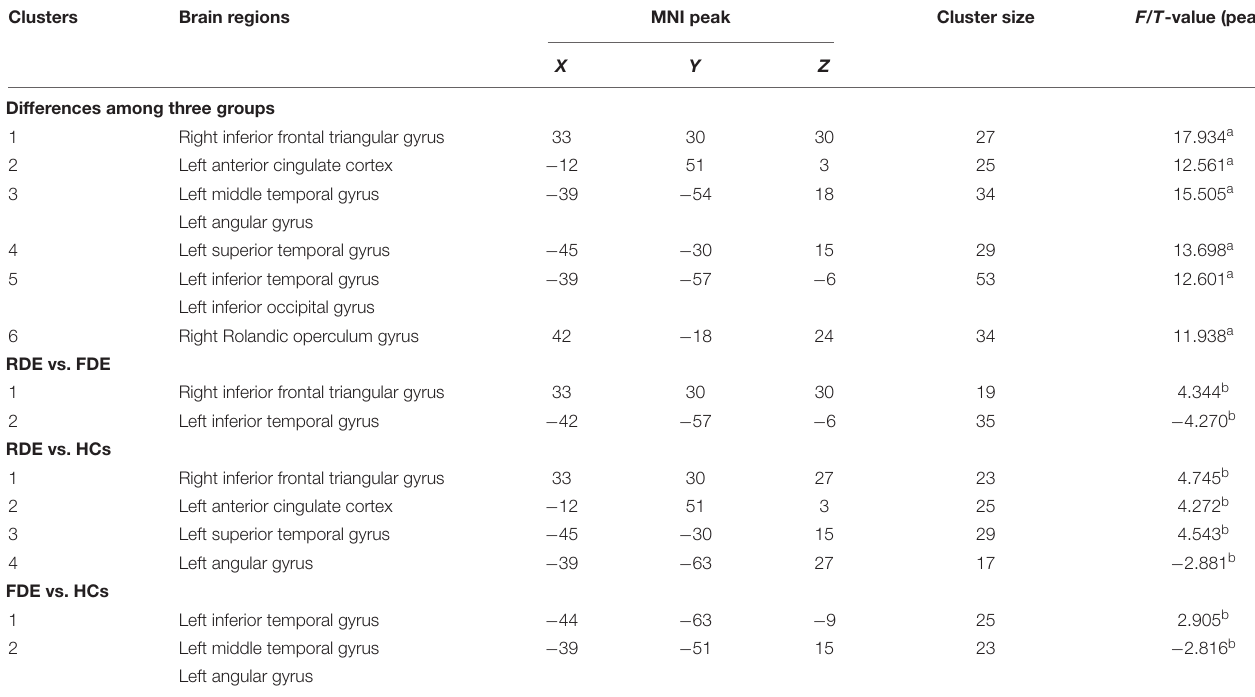
TABLE 2 | ReHo differences in RDE, FDE, and